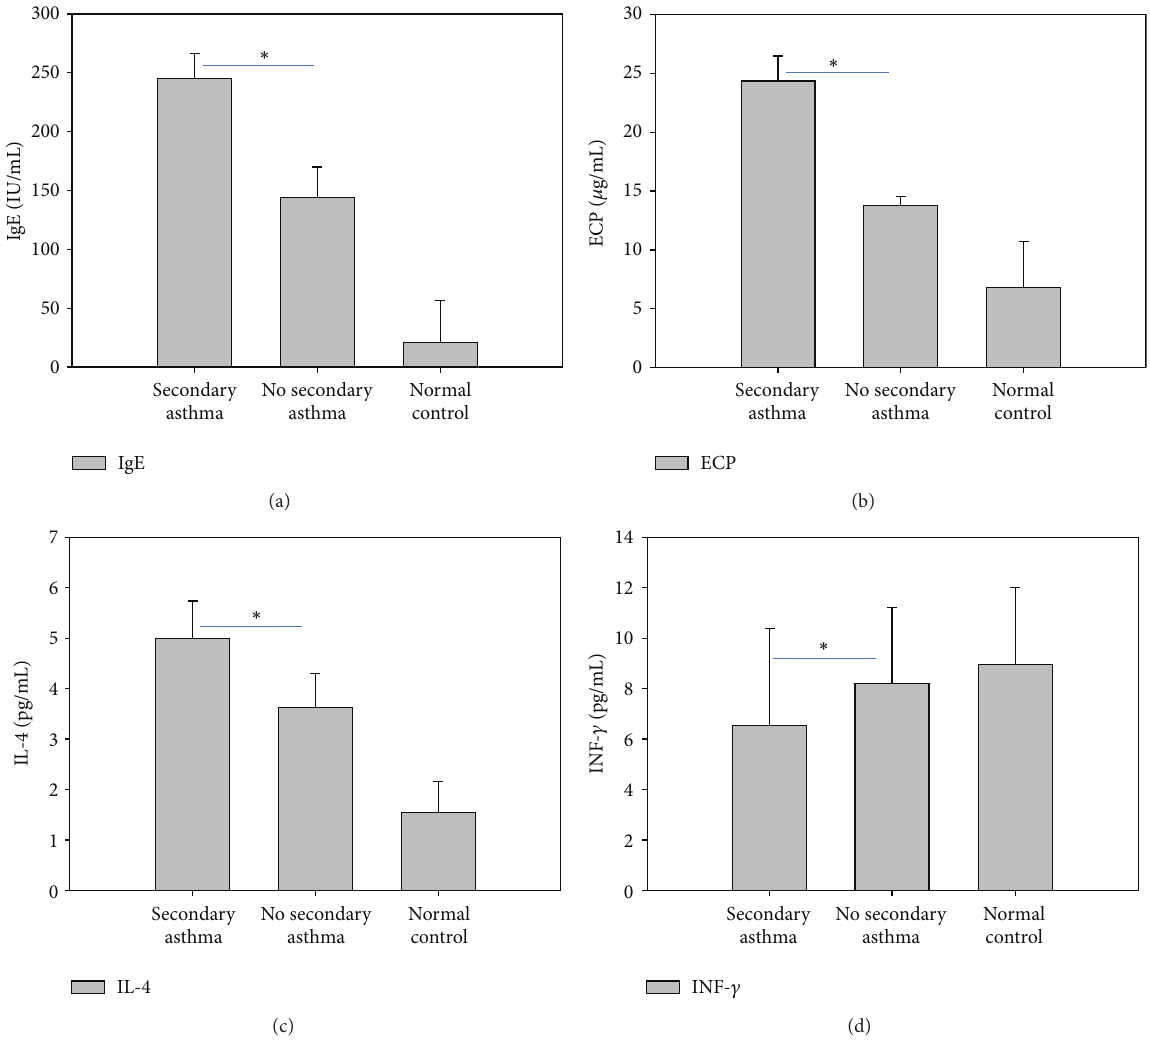
Figure 3: The IgE, ECP, and serum cytokine levels for MPP patients with allergic conditions, with or without secondary asthma. Levels of IgE, ECP, IL-4, and INF- 𝛾 were measured for MPP patients with allergic conditions who developed secondary asthma ( 𝑛 = 12) or did not develop secondary asthma ( 𝑛 = 390). The results for 𝑛 = 50 control subjects without pneumonia are shown for comparison. Results represent the mean ± standard deviation. ∗ 𝑃 < 0.01 for secondary asthma versus no secondary